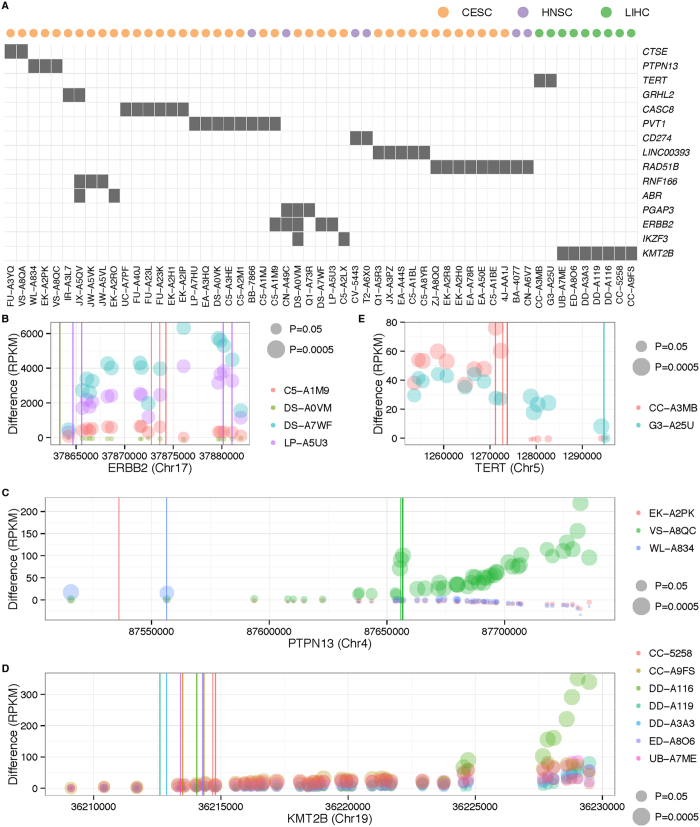
(A) Genes with recurrent virus integrations in LIHC (Green), HNSC (Purple), and CESC (Orange). The gray box indicates sample (x-axis) with virus integration in the specific gene (y-axis). (B) Differences in RPKM between case and the mean value of controls (without viral infection) for various exons in the longest transcripts of four important genes (ERBB2, PTPN13, KMT2B, TERT) with recurrent virus integrations. Circle area is proportional to −log10 of the difference p-value. The x coordinate of the circle’s center represents the mid-point of each exon, which is ordered from the left to right for positive strand gene and the right to left for negative strand gene. PTPN13, KMT2B and ERBB2 are positive strand genes and TERT is a negative strand gene. Different samples are marked by different colors.